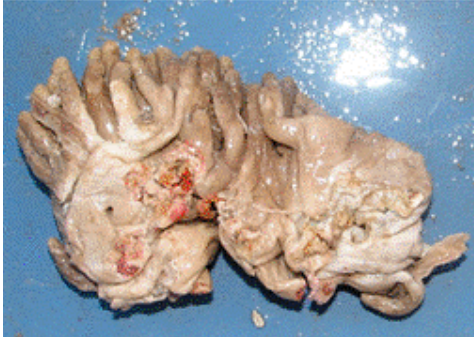
Figure 12. An image of Clavularia koellikeri ; Wang et al. (2019) [87].